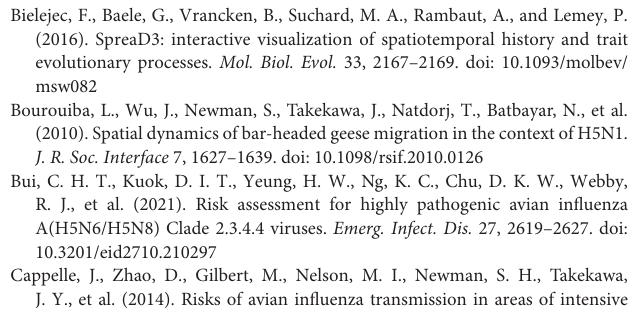
Supplementary Table 6 | Molecular features of the PA protein of avian influenza A H5 subtype viruses in this study. Supplementary Table 7 | Molecular features of the NP protein of avian influenza A H5 subtype viruses in this study. Supplementary Table 8 | Molecular features of the M1 protein of avian influenza A H5 subtype viruses in this study. Supplementary Table 9 | Molecular features of the NS1 protein of avian influenza A H5 subtype viruses in this